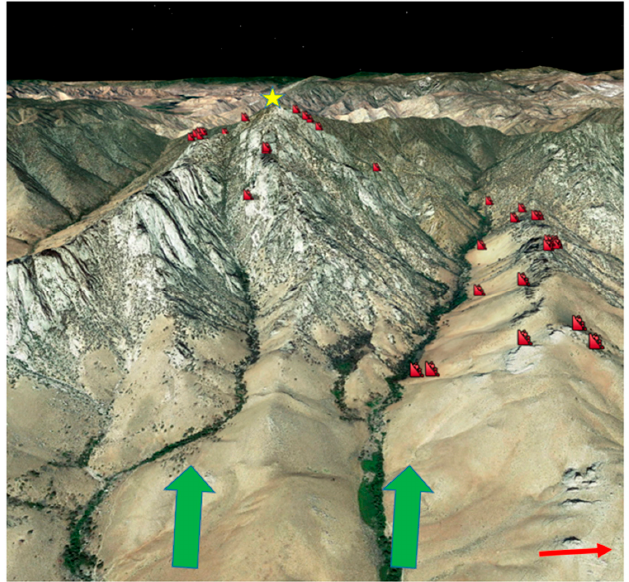
Figure 18. Owens Peak failure locations LS study site. Google Earth image looking east (imagery date 1 July 2017). Owens Peak (yellow star) is the high point at the head of the southern branch of Grapevine Canyon. The large cluster of failures (red triangles) on the right of the scene are along the northern branch of Grapevine Canyon. A second large cluster of rockfalls is located close to the summit of Owens Peak along the main Sierra Nevada crest. The seismic source produced waveforms that were oriented at ~278° (green arrows) approximately perpendicular to the orientation of the main crest of the Sierra Nevada at this location. North is indicated with a red arrow at the lower right.